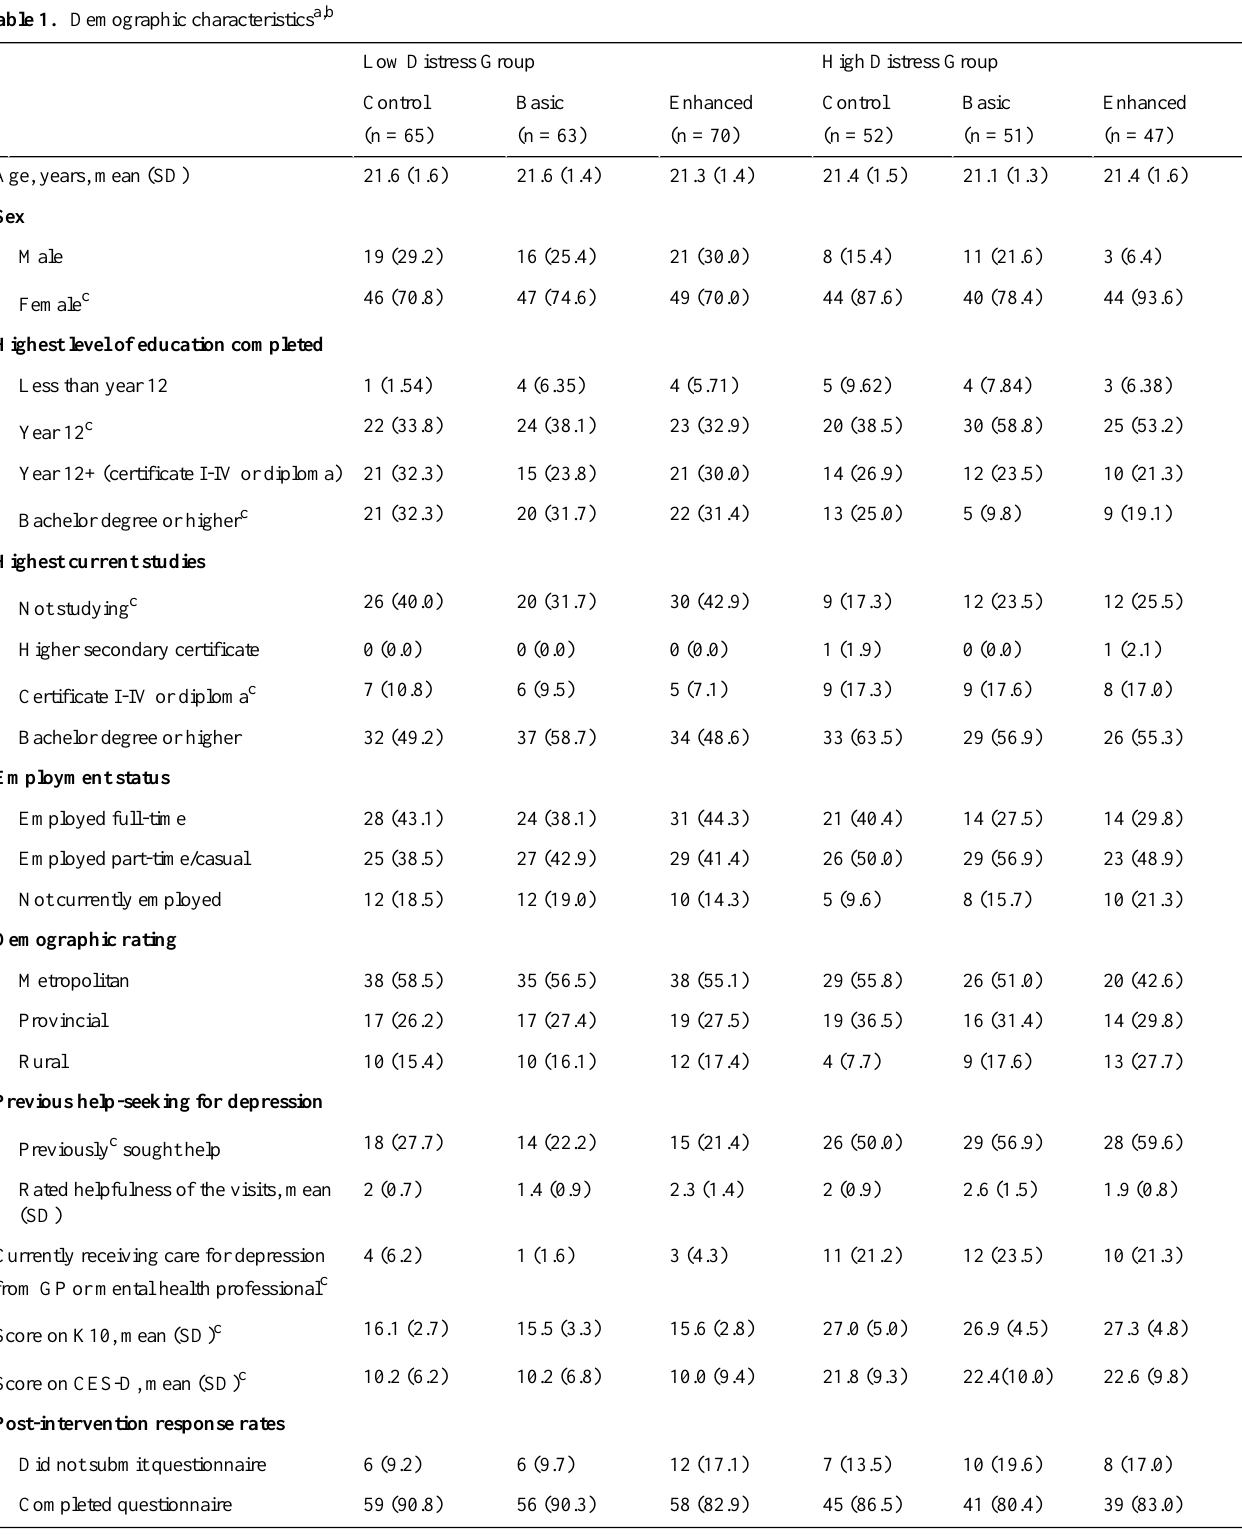
Table 1. Demographic characteristics a,b